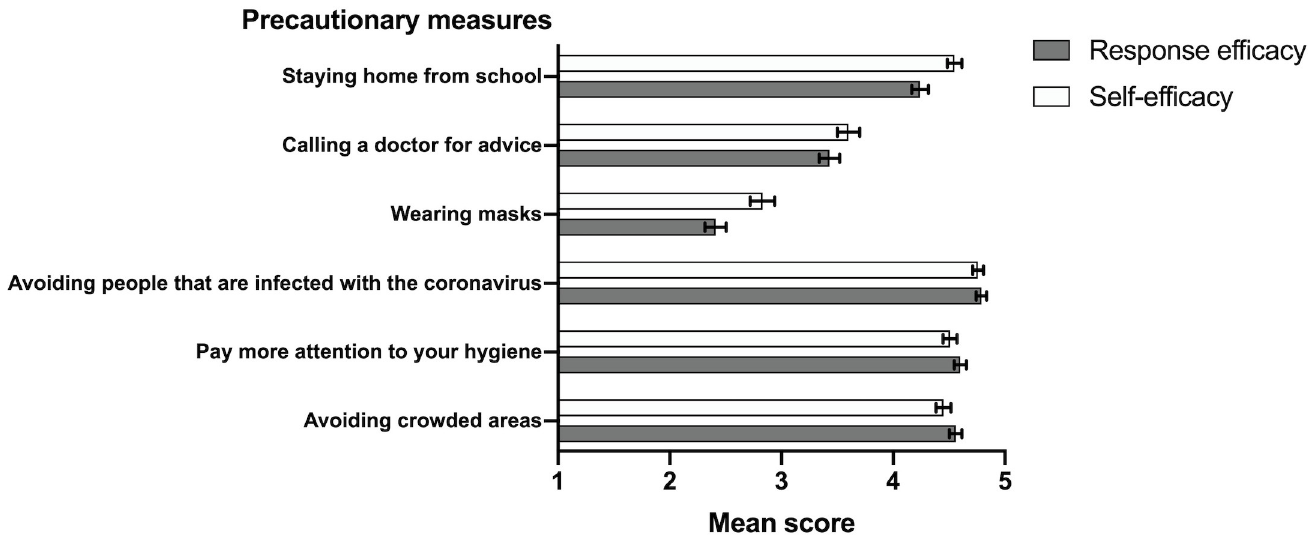
Fig 3. Mean scores of response efficacy and self-efficacy (scale 1–5) regarding five different precautionary measures to prevent COVID-19. Note : Response efficacy question: Of the following precautionary measures, do you think they will help in preventing a coronavirus infection? Self-efficacy question: If the government would advise one of these following precautionary measures, would you be capable to adhere to them? Scores: 1 = certainly not, 2 = probably not, 3 = not probable and not improbable, 4 = probably, 5 = certainly. Error bars describe 95% confidence intervals.